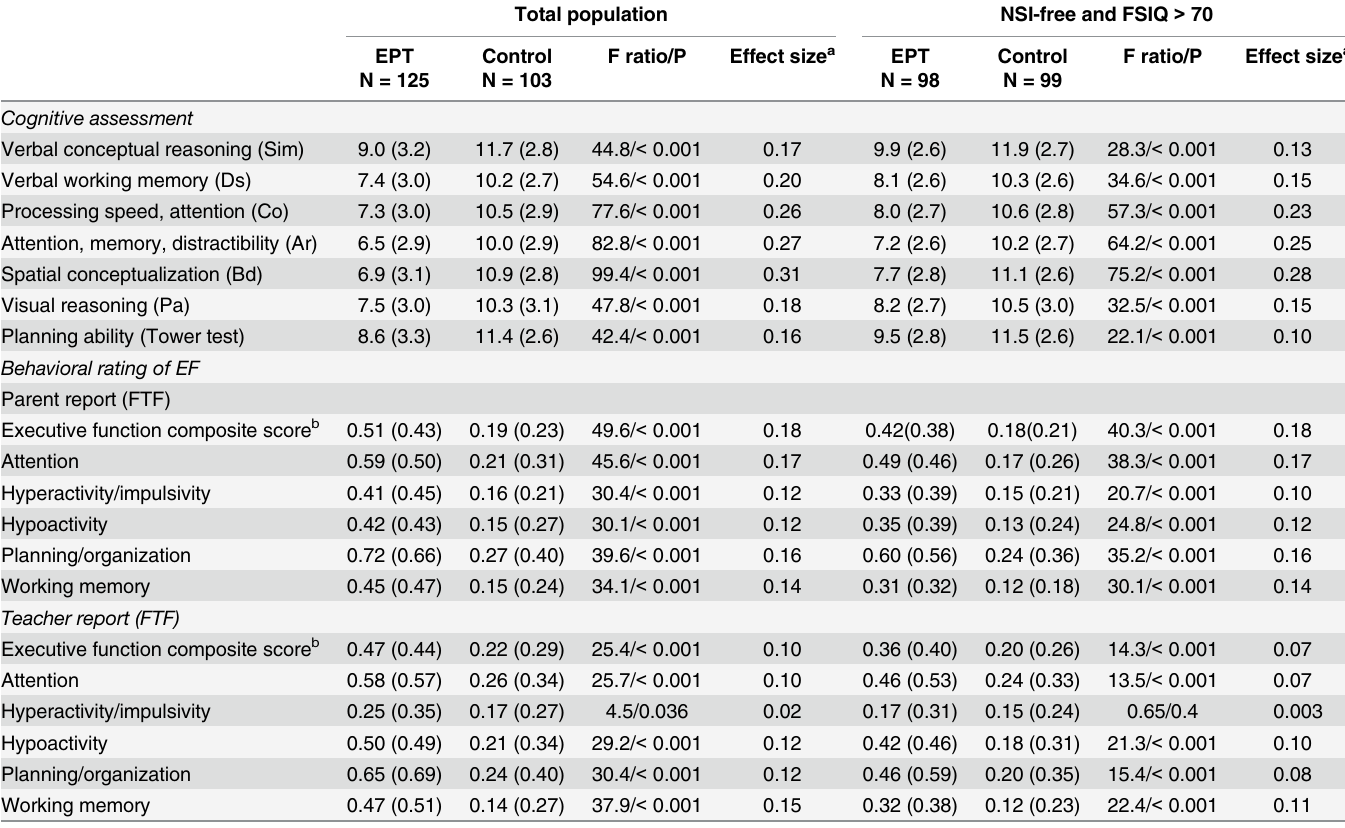
Table 2. Adjusted mean scores of the EPT and control subjects on cognitive and behavioral parameters of